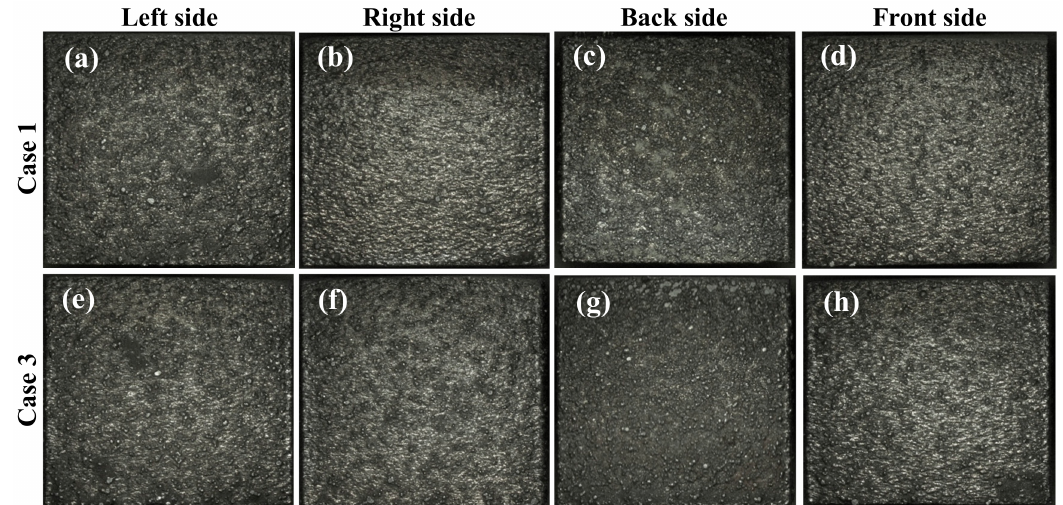
Figure 5. The side macro-morphologies with different scan strategies: case 1 with a rotation increment angle of 0 ◦ and rotation start angle of 0 ◦ , and case 3 with a rotation increment angle of 0 ◦ and rotation start angle of 90 ◦ .